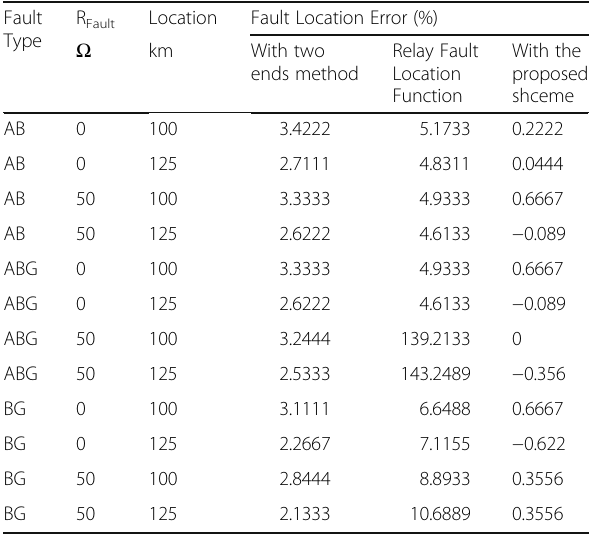
Table 3 Comparison of accuracy of different fault between S and T